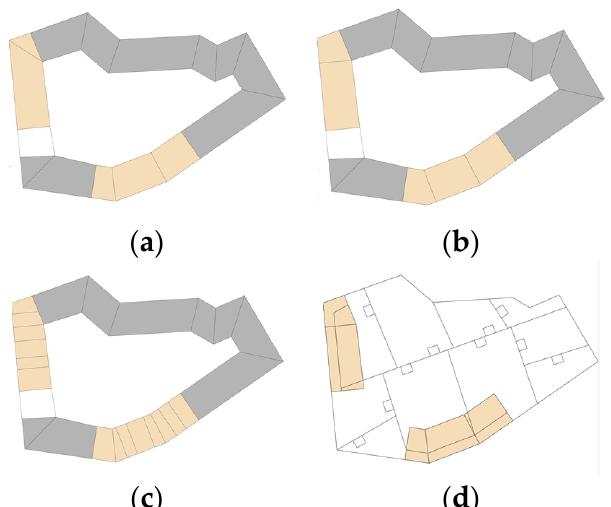
Figure 11. ( a ) Block initial strip subdivision (grey is reserved for walls, white is reserved for empty space, and orange is reserved for building land); ( b ) subdivision after BC; ( c ) parcel subdivision; and ( d ) interior block subdivision, with small parcels for interior houses.